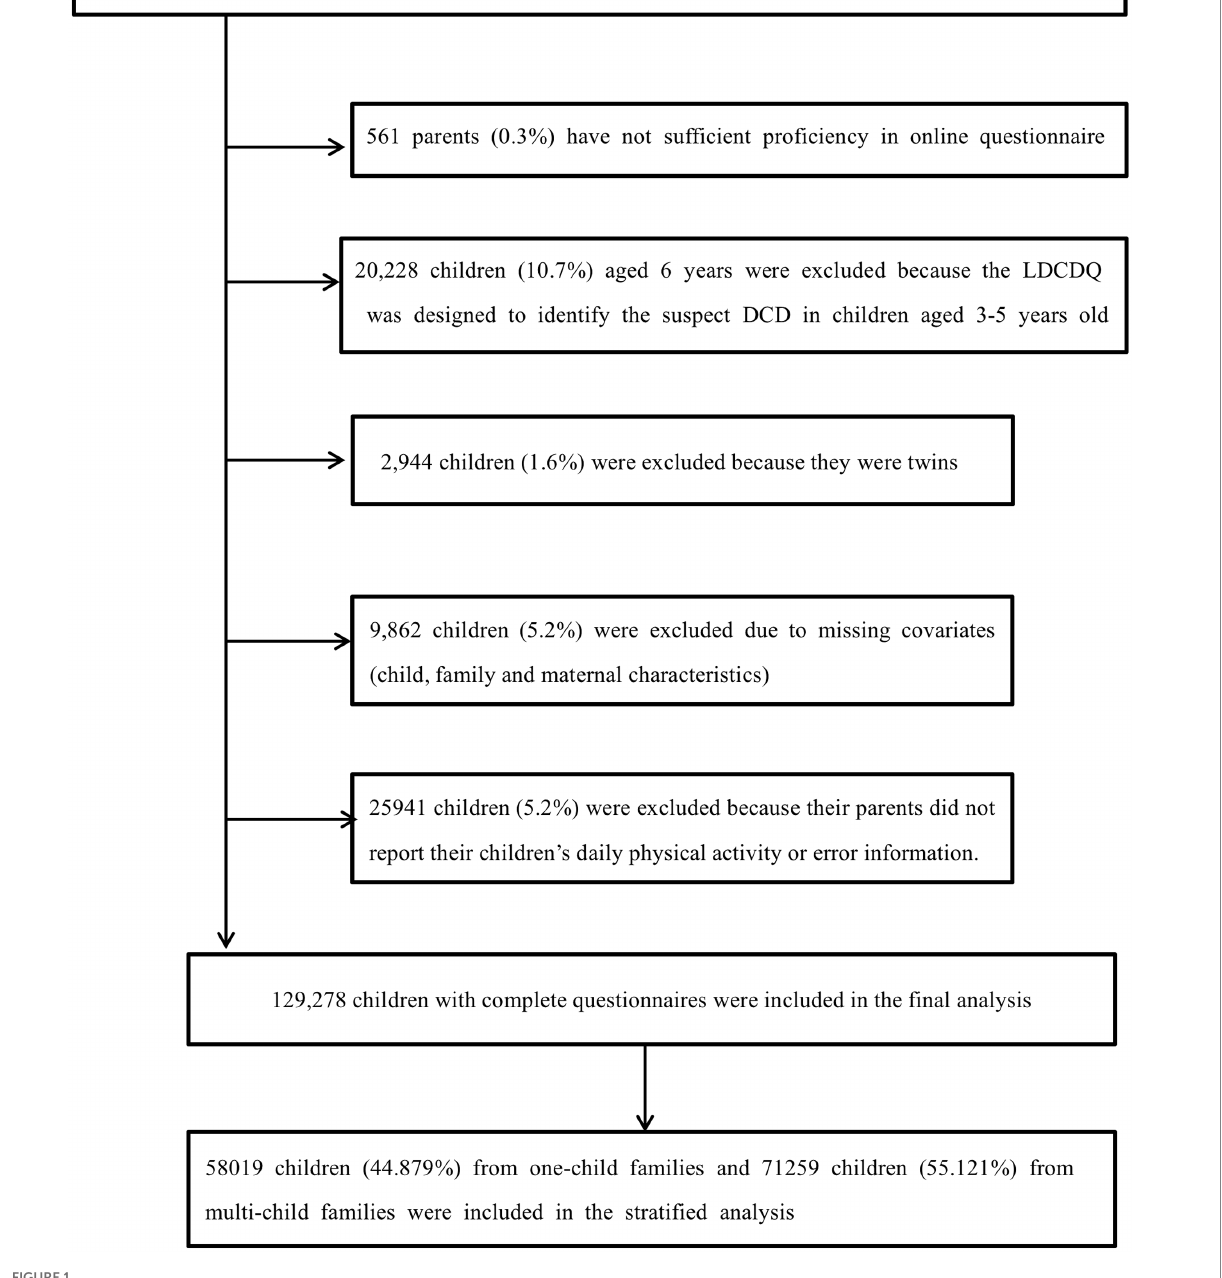
FIGURE 1 Flowchart of the study